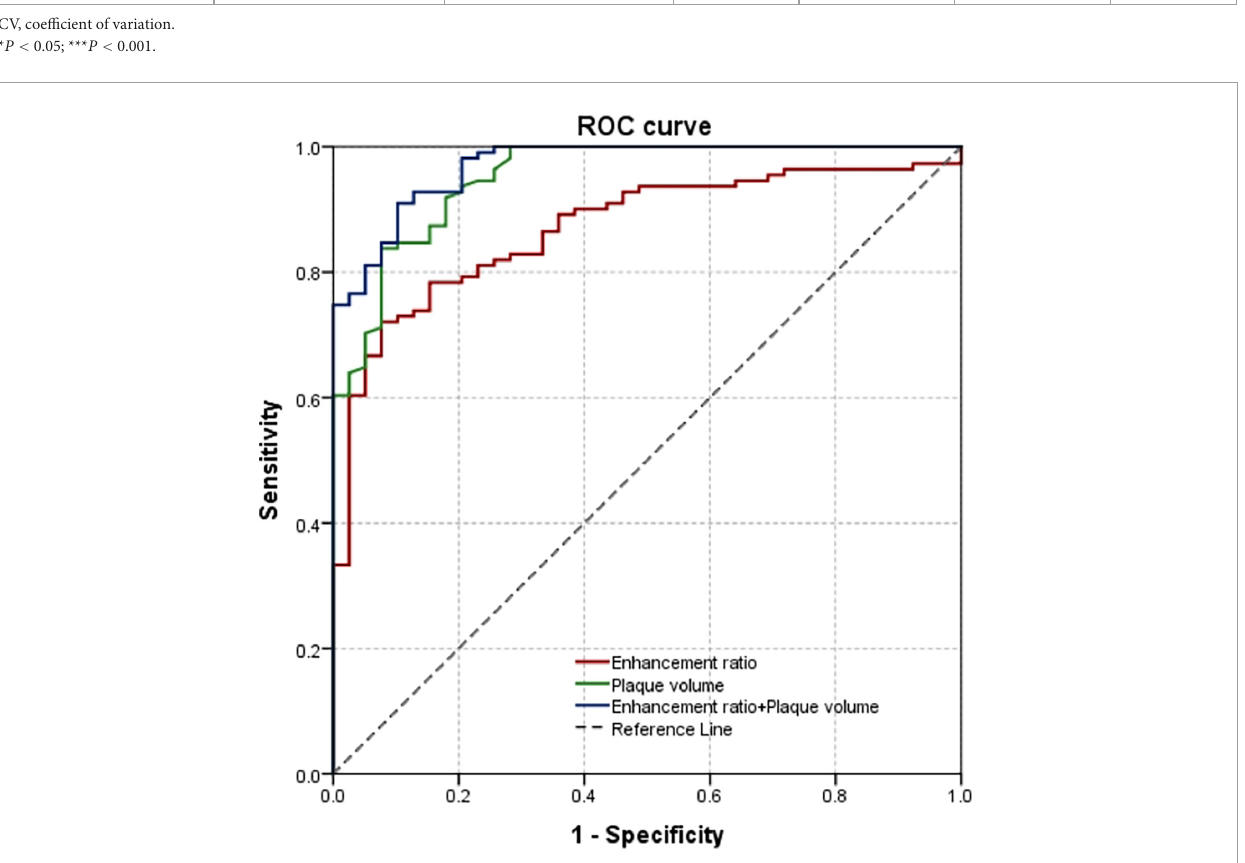
FIGURE3 Receiver operating characteristic (ROC) curve on the basis of multivariable logistic regression to differentiate culprit from non-culprit plaques.